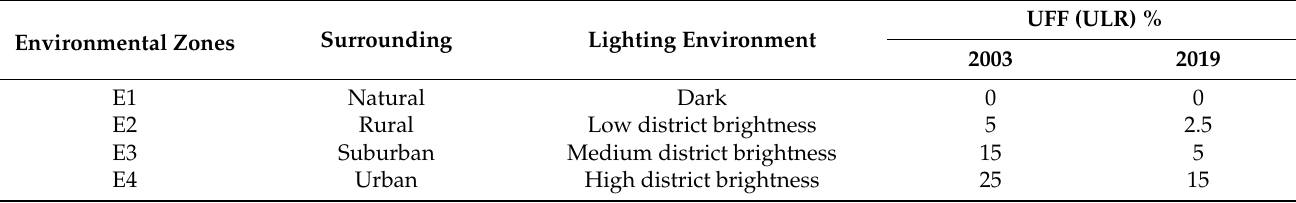
Table 6. Recommendations of CIE concerning the limit values of the luminous flux emitted into the upper half-space. Environmental Zones Surrounding Lighting Environment